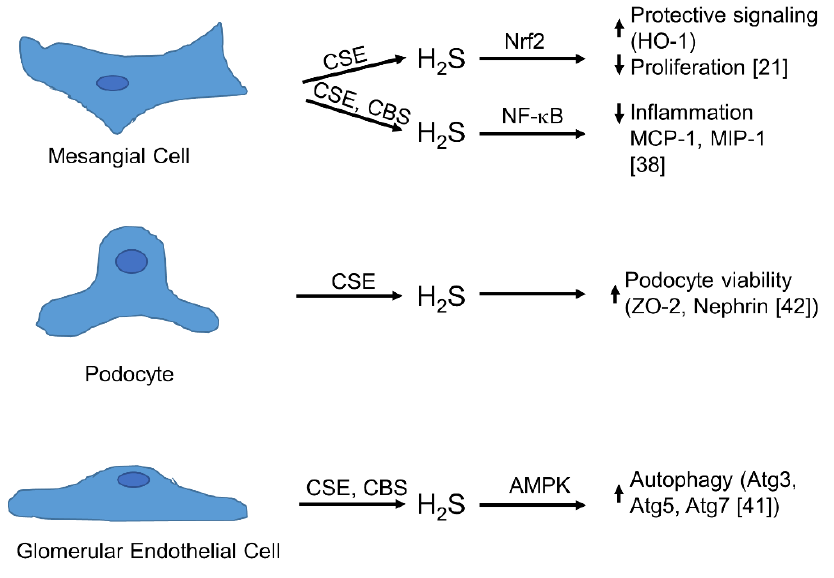
Figure 3. Synthesis and action of H 2 S in glomerular cells. Glomerular mesangial cells, podocytes and endothelial cells express CSE and CBS to produce H 2 S, which affects different cellular targets. Note that the H 2 S-producing enzyme 3-MST was characterized in whole glomeruli [37], but the expression of 3-MST cannot, so far, be assigned to a special cell type. Atg, autophagy related; CBS, cystathionine-b-synthase; CSE, cystathionine-g-lyase; HO-1, haem oxygenase 2; 3-MST, 3-mercaptopyruvate sulfurtransferase; MCP-1, monocyte chemoattractant protein-1; MIP-1, mac- rophage inflammatory protein 1; ZO-2, Zonula occludens protein 2.